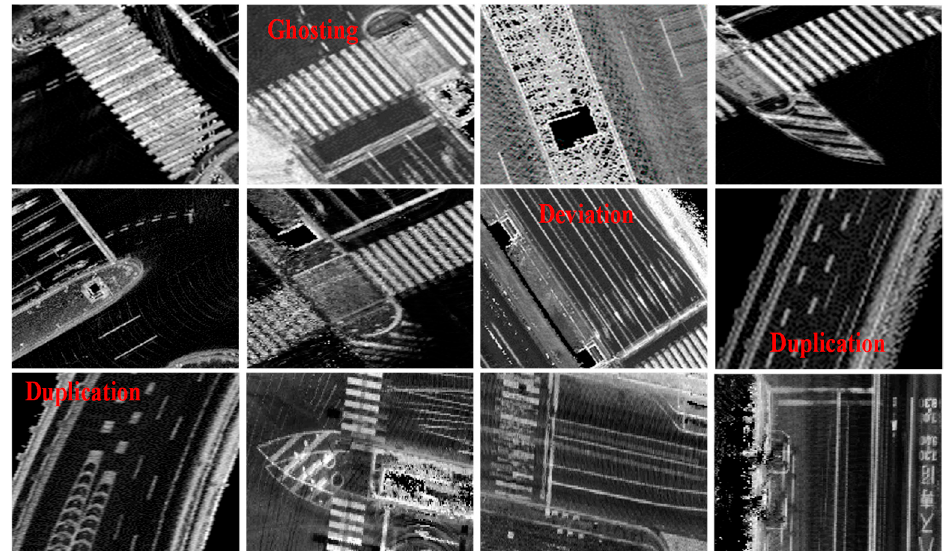
Figure 3. Different patterns of ghosting and duplications in distorting the road surface by GIR systems.